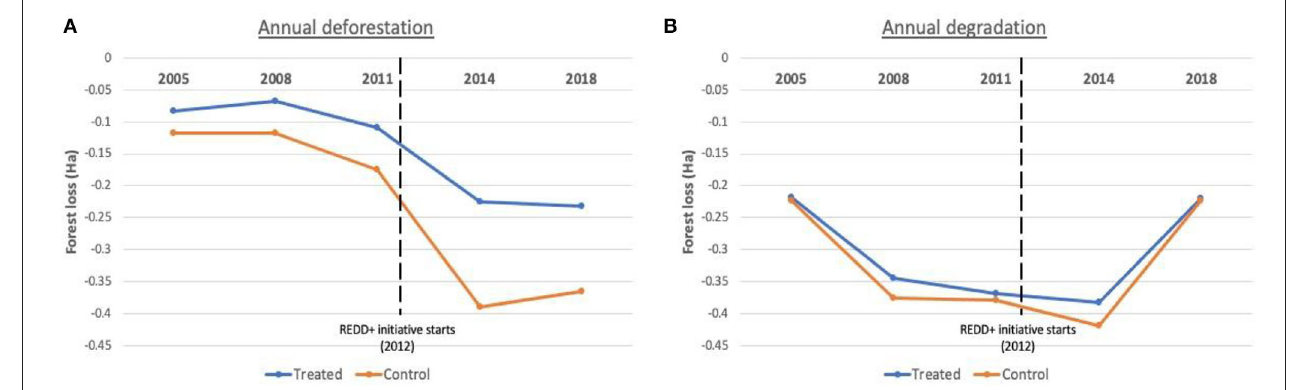
FIGURE 4 | Trends in land-cover related outcomes at concession-level by groups. (A) Corresponds to concession-level average annual deforestation in control and treated groups, and (B) to concession-level average annual degradation area in both groups.